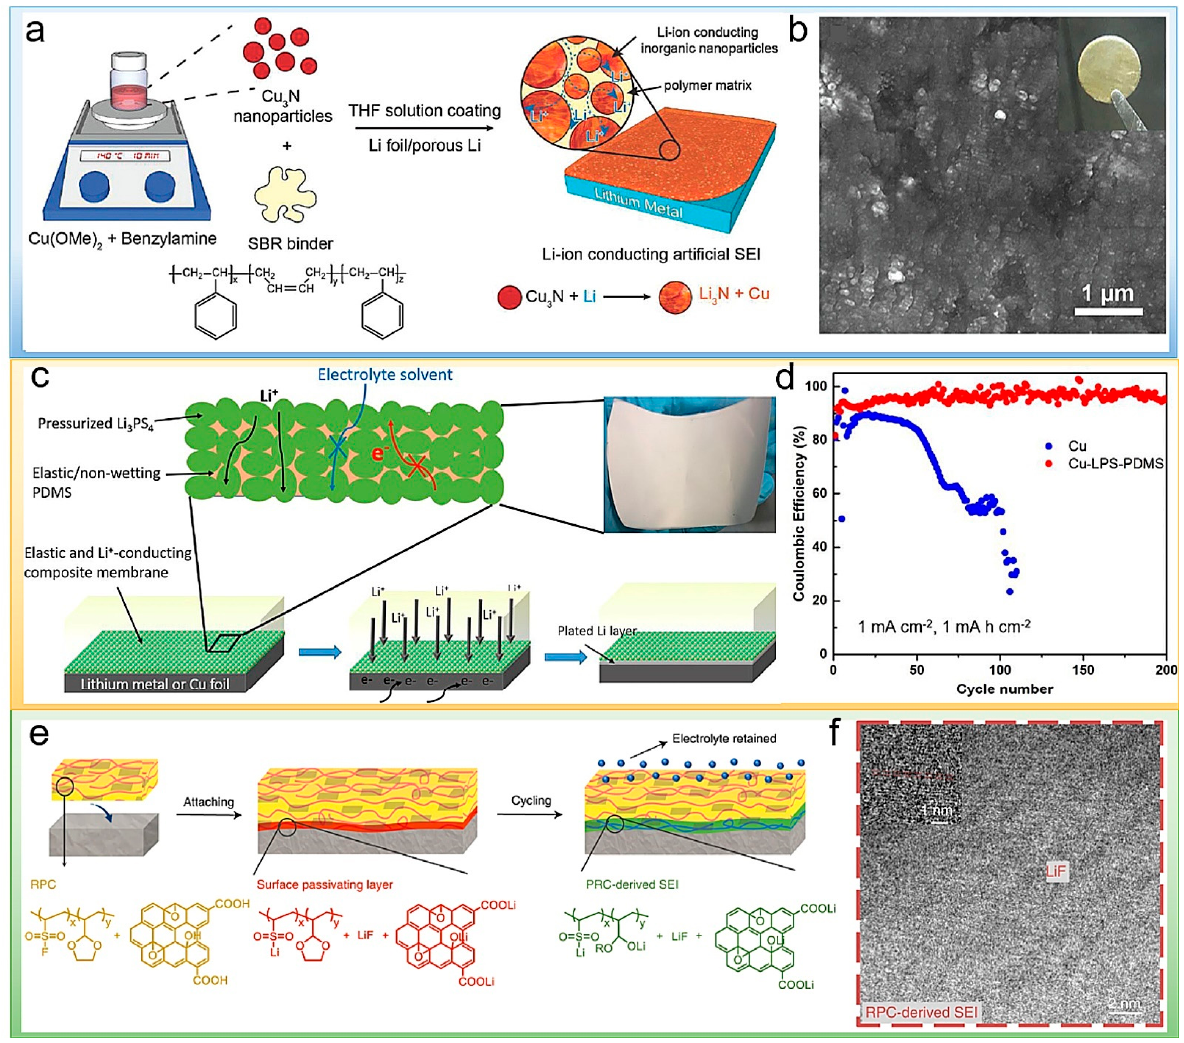
Figure 5. ( a ) Schematic illustration of the fabrication of the Cu 3 N + SBR composite artificial SEI. ( b ) SEM image and digital photography of the Cu 3 N + SBR protected Li metal foil [52]. Reproduced with permission. Copyright 2020, John Wiley and Sons. ( c ) Schematic illustration of the designed structure of the hybrid films coated on Li or Cu foils and optical photographs of the films. ( d ) The CE evolution of Li plating/stripping on the bare Cu and LPS-PDMS–coated Cu (Cu–LPS-PDMS) over cycling (1 mA cm − 2 ,1 mAh cm − 2 ) [55]. Reproduced with permission. Copyright 2018, National Academy of Sciences of the United States of America. ( e ) The RPC layer first forms a dense layer (red) by chemically passivating Li surface products. The attached RPC subsequently forms the SEI layer (green). Unreacted RPC (yellow). ( f ) TEM images of the interface of RPC-stabilized Li [60]. Reproduced with permission. Copyright 2019, Springer